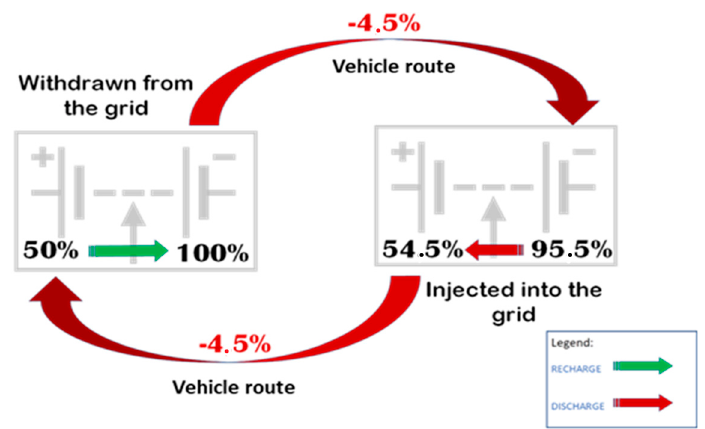
Figure 2. EV battery cycle of use hypnotized in the simulations.